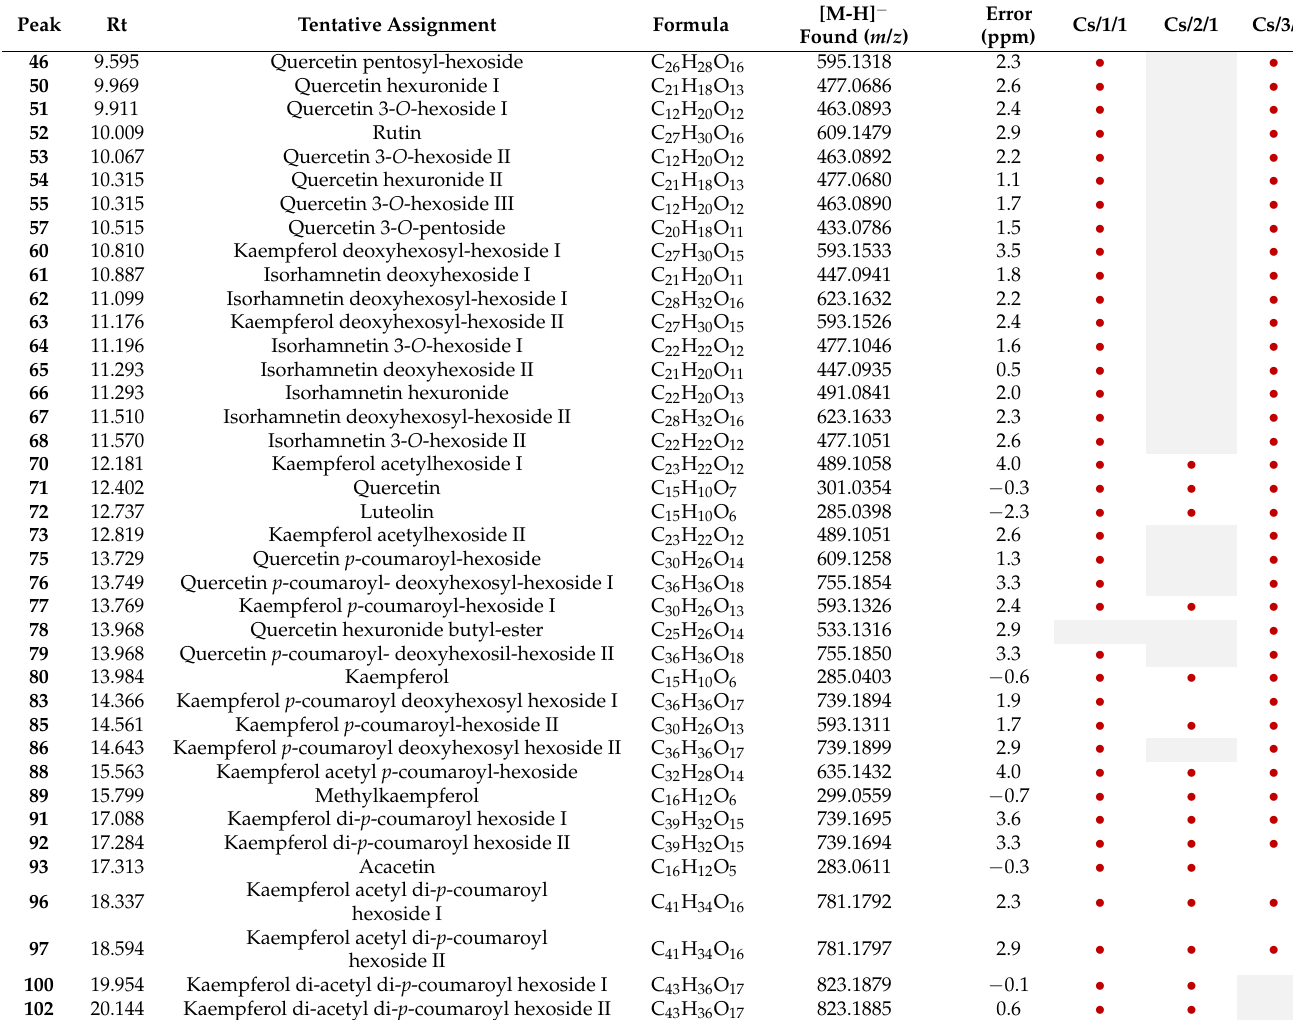
Table 3. Flavonoid compounds tentatively identified in the chestnut Cs/1/1 alcoholic extract